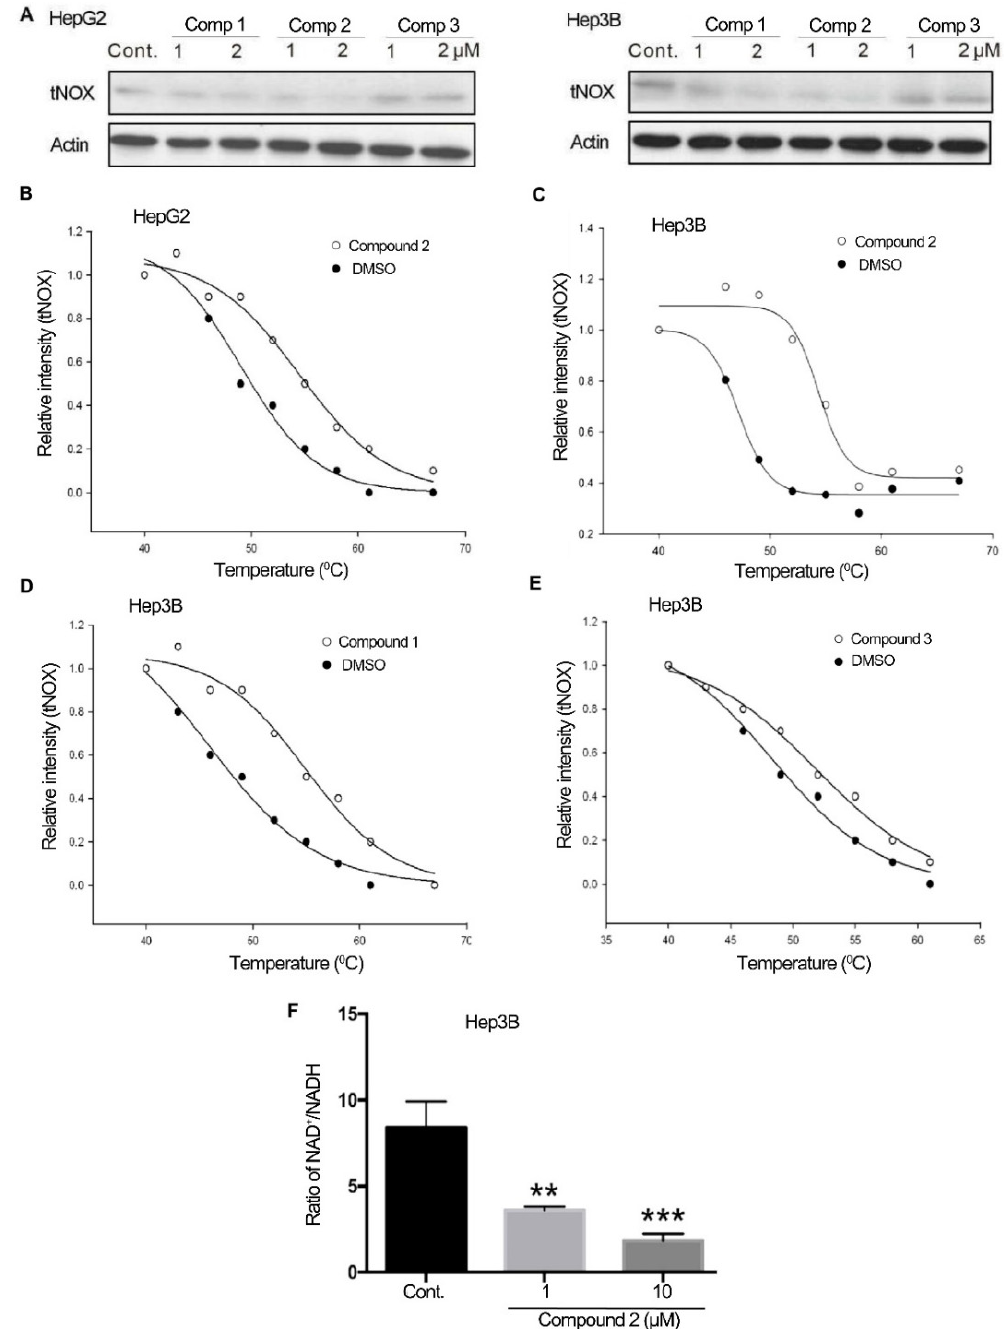
Figure 3. Effects of selected derivatives on tNOX expression and CETSA-based determination of binding between those compounds and tNOX. ( A ) Cells were treated with different concentrations of compounds or vehicle for 24 h, and cell lysates were separated by SDS-PAGE and analyzed by Western blotting. ( B – E ) CETSA curves of tNOX in p53-wild-type HepG2 cells ( B ) and p53-deficient Hep3B cells ( C , D , E ) were determined in the absence and presence of different compounds, and cell lysates were separated by SDS-PAGE and analyzed by western blotting. β -Actin was used as an internal control. Representative images are shown. The band intensities of tNOX were normalized with respect to the intensity at 40 °C. The denaturation midpoints were determined using a standard process. ( F ) Derivative 2 dose-dependently reduces the NAD + /NADH ratio in Hep3B cells. Cells were treated with vehicle or compound 2 , the NAD + and NADH levels in cell extracts were quantified based on the optical density at 450 nm, and the NAD + /NADH ratio was calculated. Values (mean ± SEs) were obtained from at least three independent experiments.